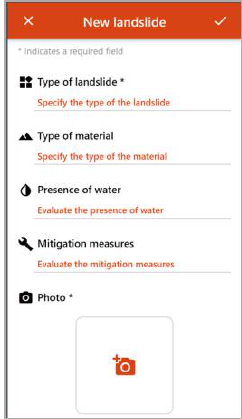
Figure 5. LandslideSurvey - Form to insert a new landslide